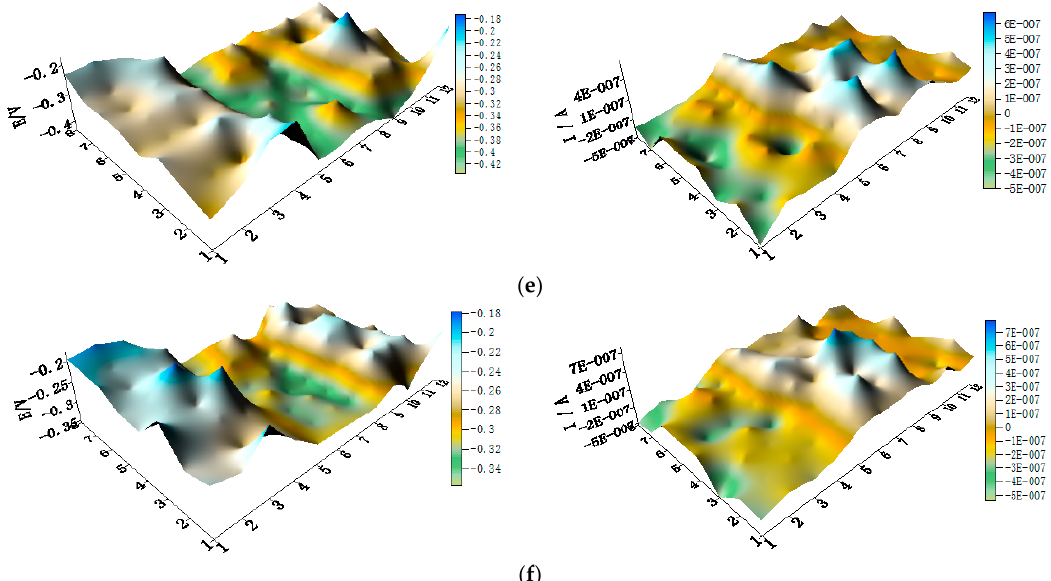
Figure 13. Spatial potential ( left , V/SCE) and corresponding current ( right , I/A) distribution maps of CMEA3 after being short-circuited for 12 h in artificial seawater with different concentrations of chloride ions (wt %): ( a ) 1.5%; ( b ) 1.7%; ( c ) 1.9%; ( d ) 2.1%; ( e ) 2.3%; and ( f ) 2.5%.